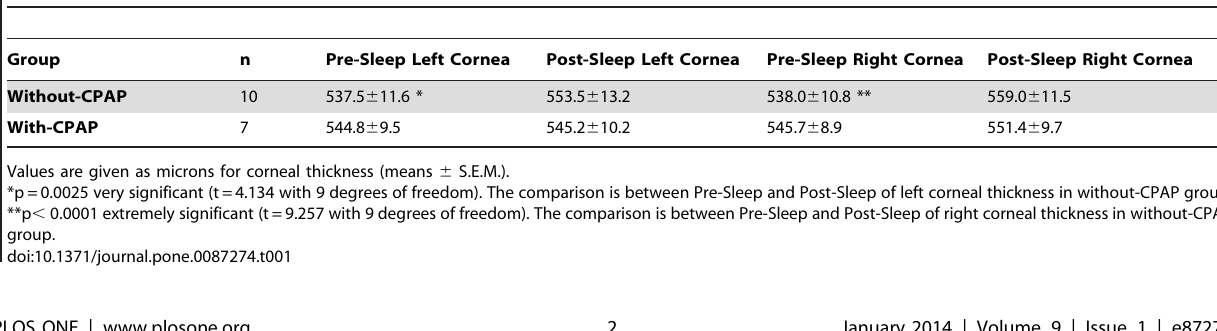
Table 1. Pre and post sleep comparison of left and right corneal thickness of each group.